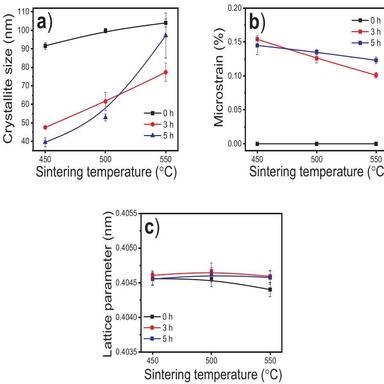
a) Crystallite sizes, b) microstrains, and c) lattice parameters of the matrixes of Al-Cu-Mg/WC composites prepared with different milling times as functions of sintering temperature.